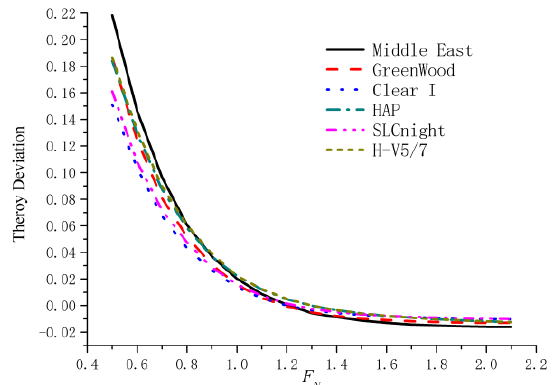
Figure 5. Theoretical deviation of the covariance method with different F N and various typical turbulence models when d/D = 0.53.